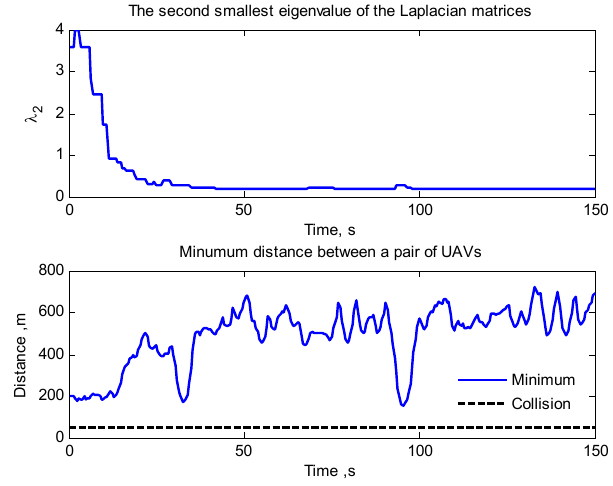
Figure 8. Topology connectivity and minimum distance between UAVs.